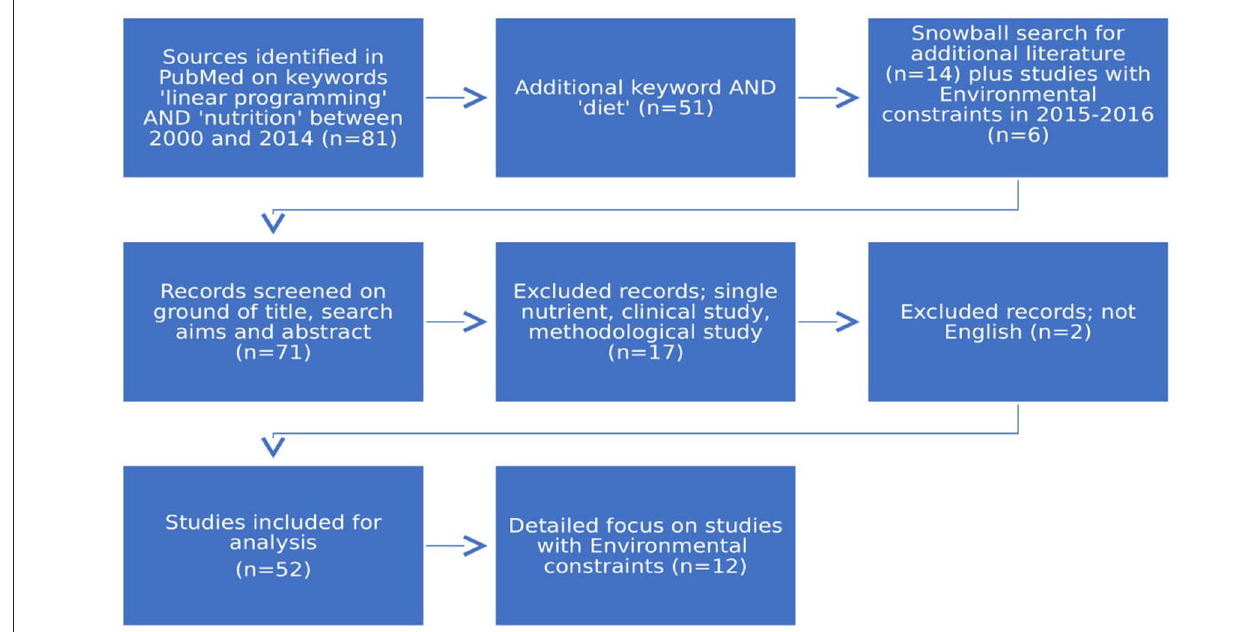
FIGURE 2 | Selection of papers through the PRISMA protocol for systematic literature research.